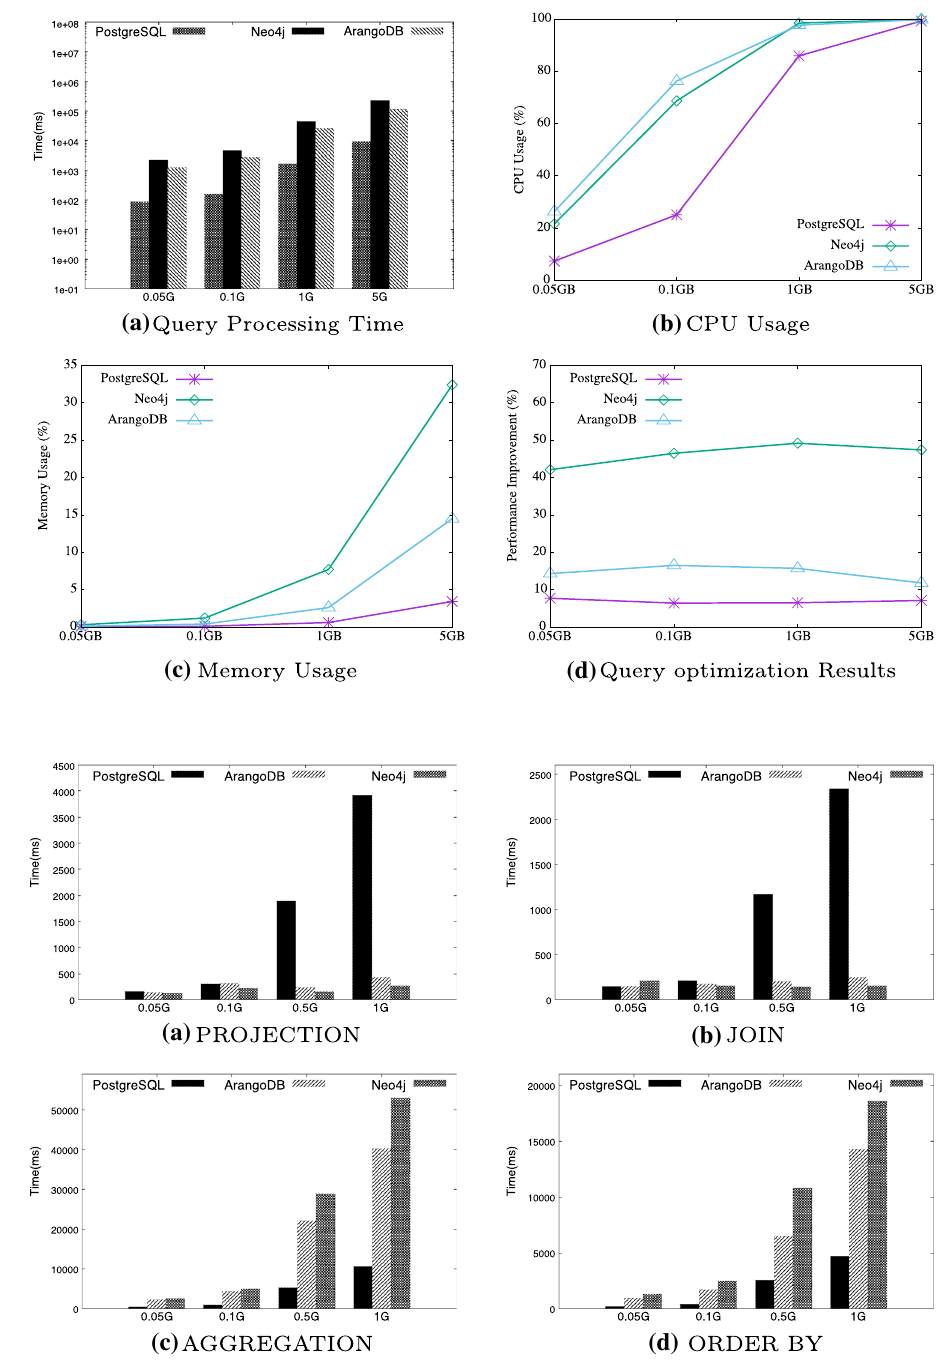
Fig. 7 Relational operation test